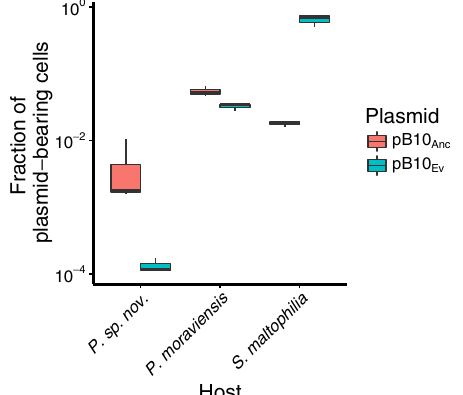
Fig. 5 Plasmid persistence of ancestral plasmid pB10 Anc and truncated plasmid pB10 ev in three additional hosts. Persistence was determined by plate counting after 8 days, showing that the plasmid deletion was only bene fi cial to persistence in Stenotropho- monas maltophilia . (P = Pseudomonas ). Boxes represent the median and the fi rst and third quartiles, and the whiskers the lower and upper 1.5 interquartile